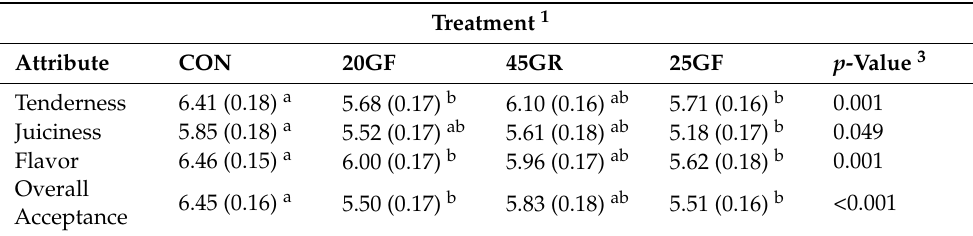
Table 3. Mean scores ( ± standard error) of four sensory attributes of steaks derived from animals under different feeding systems assessed in the consumer tasting panel evaluation 2